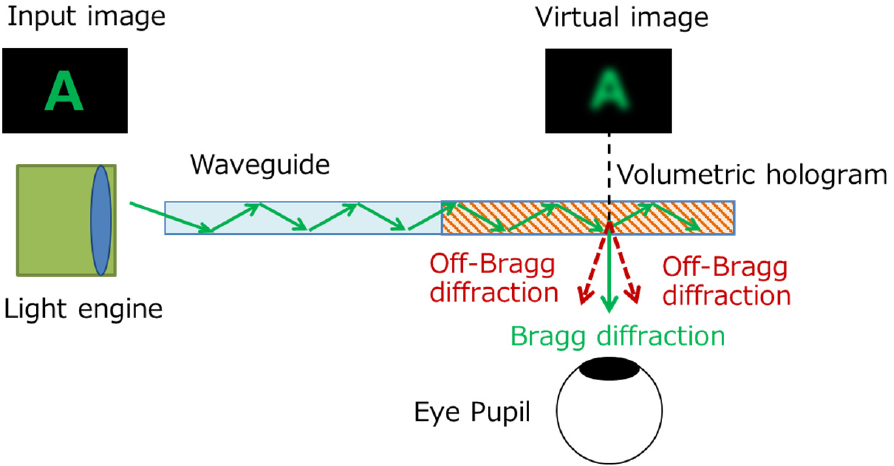
Figure 1. HMD optical system with volume holographic waveguide and conceptual diagram of degraded image resolution by off-Bragg diffraction.